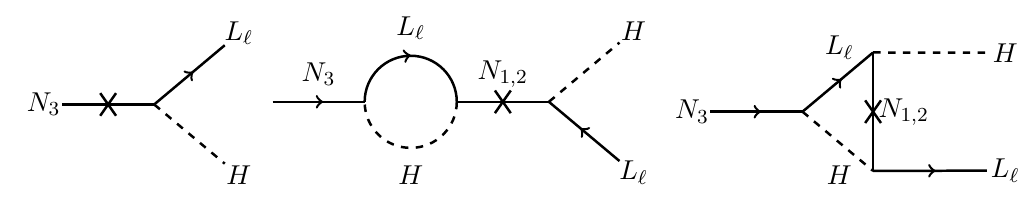
Figure 7 . Feynman diagrams contributing to the CP asymmetry (cid:15)